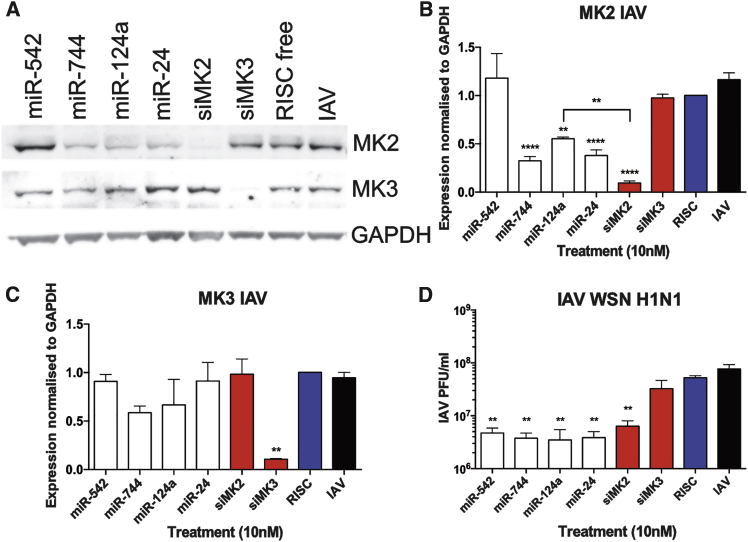
Role of MK2 Suppression in IAV Infection(A) Representative western blot analysis of MK2 and MK3 expression in A549 cells transfected with 10 nM miRNA mimics, siMK2, siMK3, or controls for 48 hr. Cells were subsequently infected with IAV WSN at MOI 3 for 24 hr. (B and C) Quantitative analysis of (B) MK2 or (C) MK3 total protein levels during IAV infection normalized to GAPDH shown as the mean ± SEM of n = 4. (D) IAV viral titer is shown as the mean ± SEM of n = 4. Significant differences between RISC-free siRNA control and miRNA or siRNA treatments are indicated (*p < 0.05, **p < 0.01, and ****p < 0.0001, one-way ANOVA).